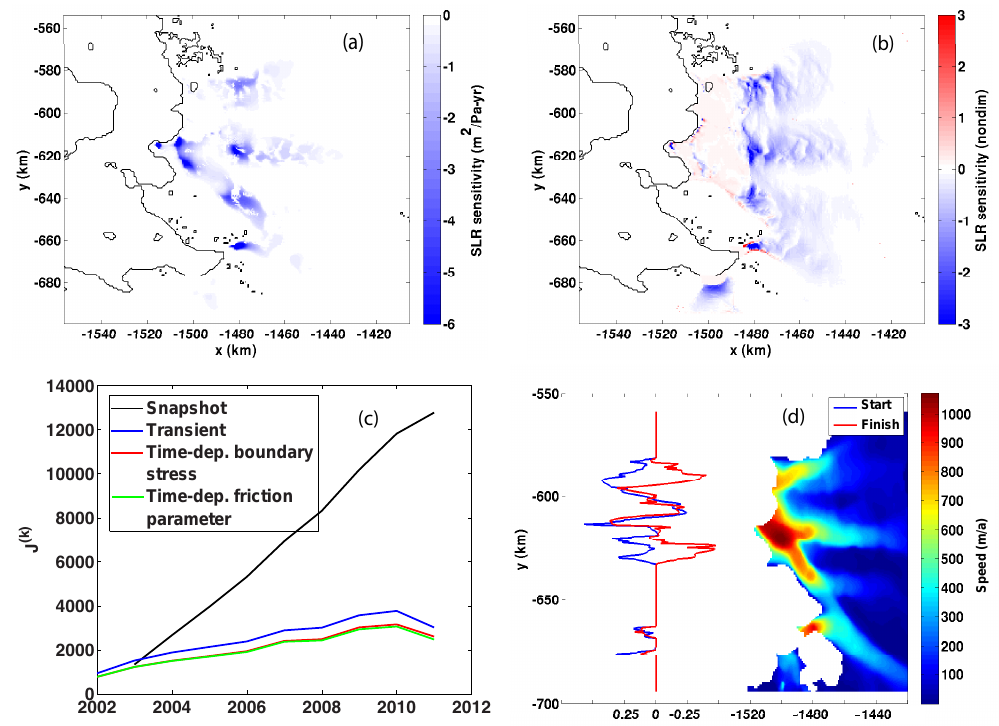
Figure 7. Sensitivity of grounded volume (Volume above floatation, or VAF) loss from the domain over the 40-year integration to (a) the sliding parameter β 2 and (b) bed topography R (see Sect. 6.1 above for explanation). (c) Annual cost functions (cf. Eq. 10) for various calibrated model runs. (d) − γ (x) σ (cf. Eq. B3) at the initial and final times in the “time-dep. boundary stress” estimation referred to in (c) . Values are plotted relative to the red curve in Fig. 4c. (Note the difference in scale from Fig.